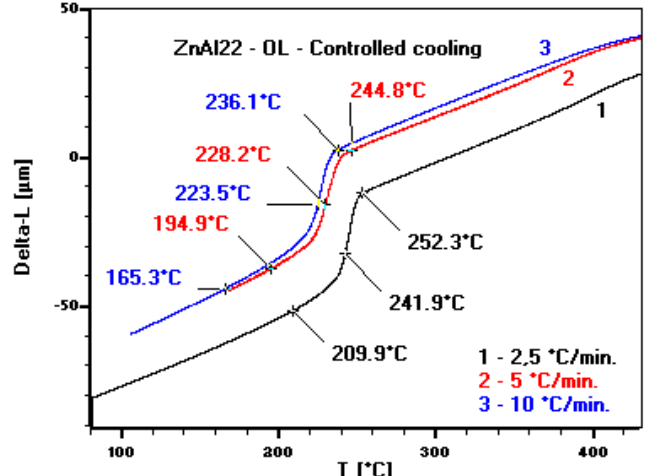
Figure 10. Contraction curves registered for the alloy produced by gravity cast with steel die during controlled cooling.